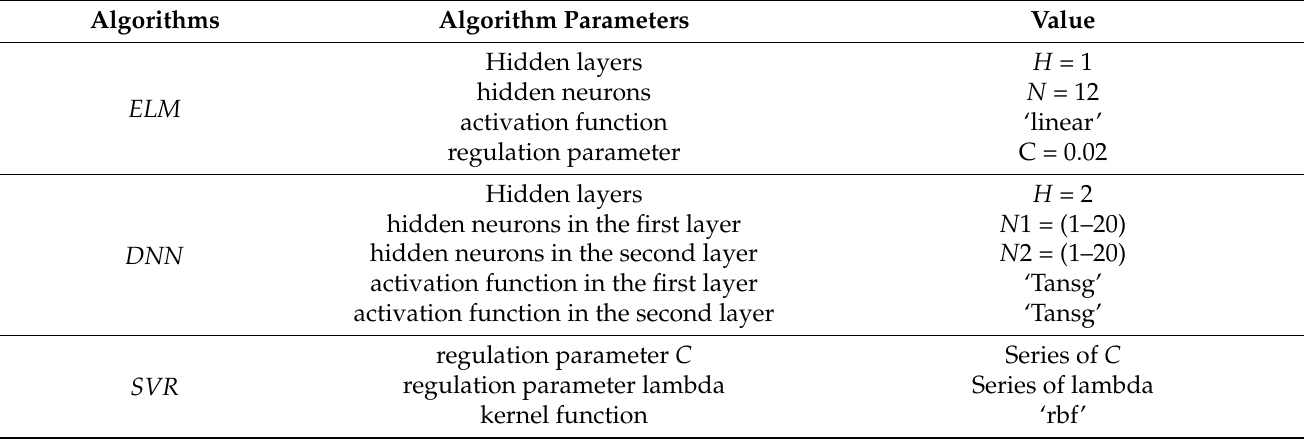
Table 3. Initial parameter settings for the